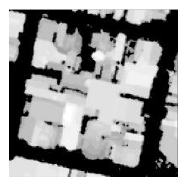
Fig.6. Extracted nDSM in feature extraction